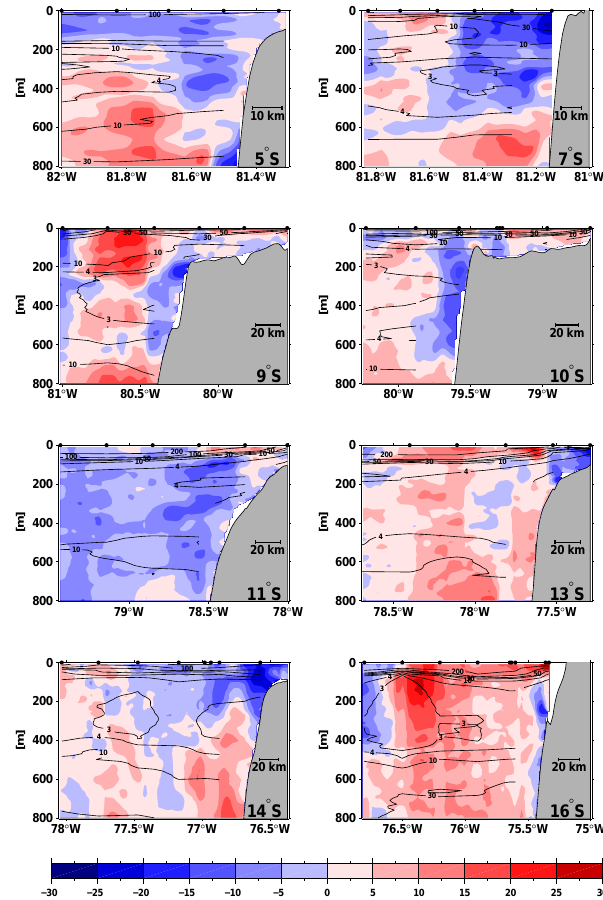
Figure 4. Smoothed cross section velocity component parallel to the coast in cms − 1 (positive northwestward) for sections perpen- dicular to the coast near the Peruvian shelf (see Fig. 1) at about 5, 7, 9, 10, 11, 13, 14, and 16 ◦ S in December 2012. Included are se- lected smoothed oxygen contours in µmolkg − 1 as black lines. CTD station locations are marked by black dots at the